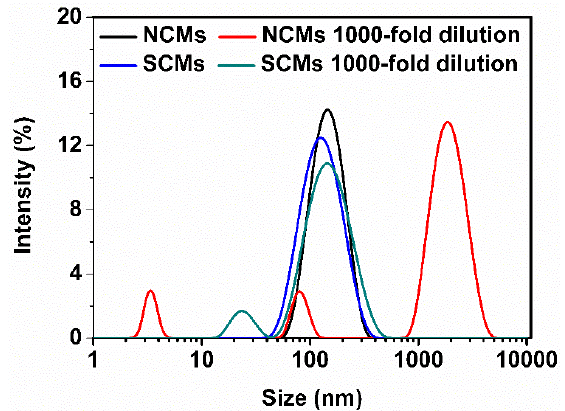
Figure 7. Size distribution of non-crosslinked micelles (NCMs) and reversible crosslinked micelles (SCMs) based on copolymer mixture before and after the 1000-fold water dilution.